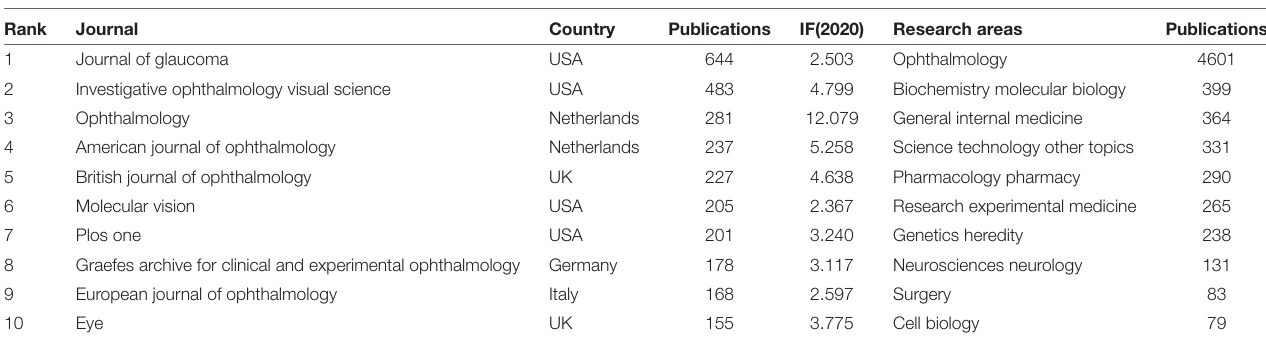
TABLE 3 | The top 10 journals and research areas in the study of